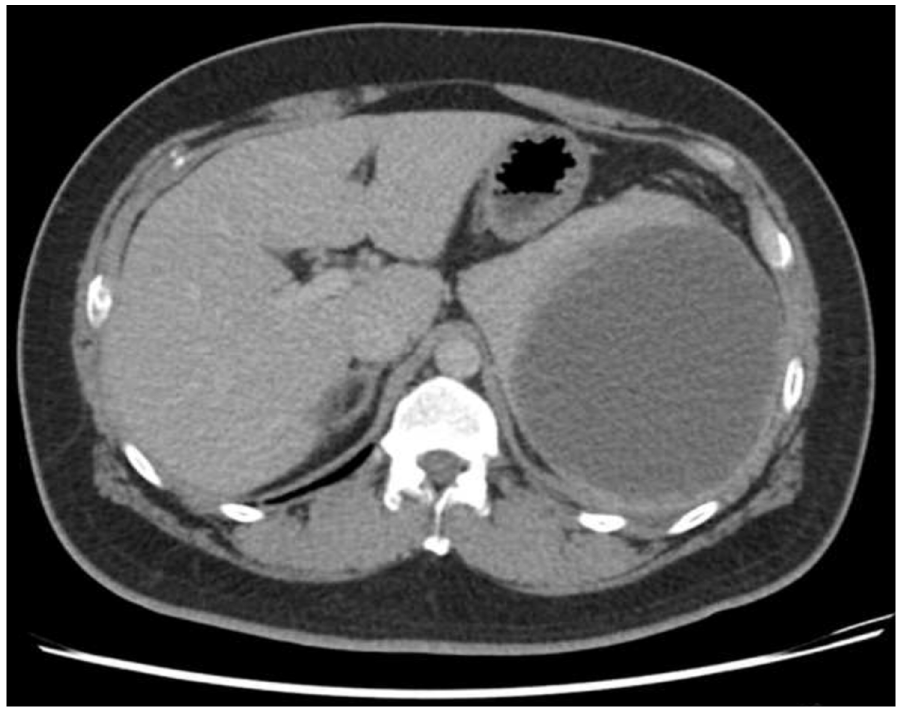
Figure 2. Abdominal CT scan revealed a large cystic splenic mass measuring 14 cm without enhancement.